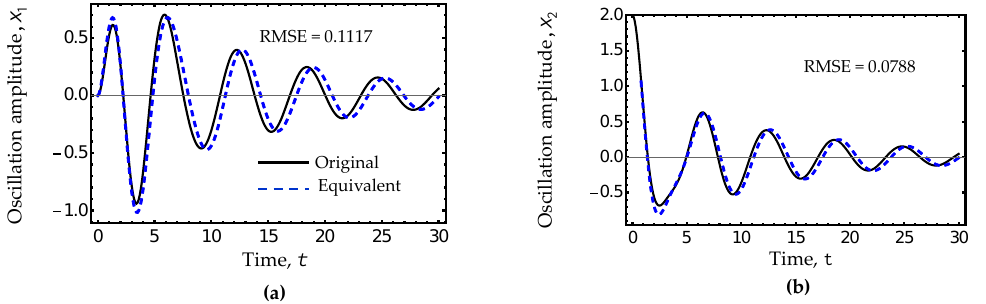
Figure 3. Time-amplitude response curves ( a ) x 1 vs t , ( b ) x 2 vs t . These were computed from the numerical integration solutions of Equations (29) and (30). The parameter values used to obtain these plots were 𝑚 1 = 𝑚 2 = 1 , 𝑘 = 1 , 𝜀 = 0.5 with 𝑐 = 0.3 , with initial conditions given by (𝑥 1 ,𝑥 2 ,𝑥̇ 1 ,𝑥̇ 2 ) = (0,0,2,0) . Here, the black lines describe the numerical integration solutions of Equation (30), while the blue, dashed lines represent the numerical solutions obtained from the nonlinear equations of motion (29).